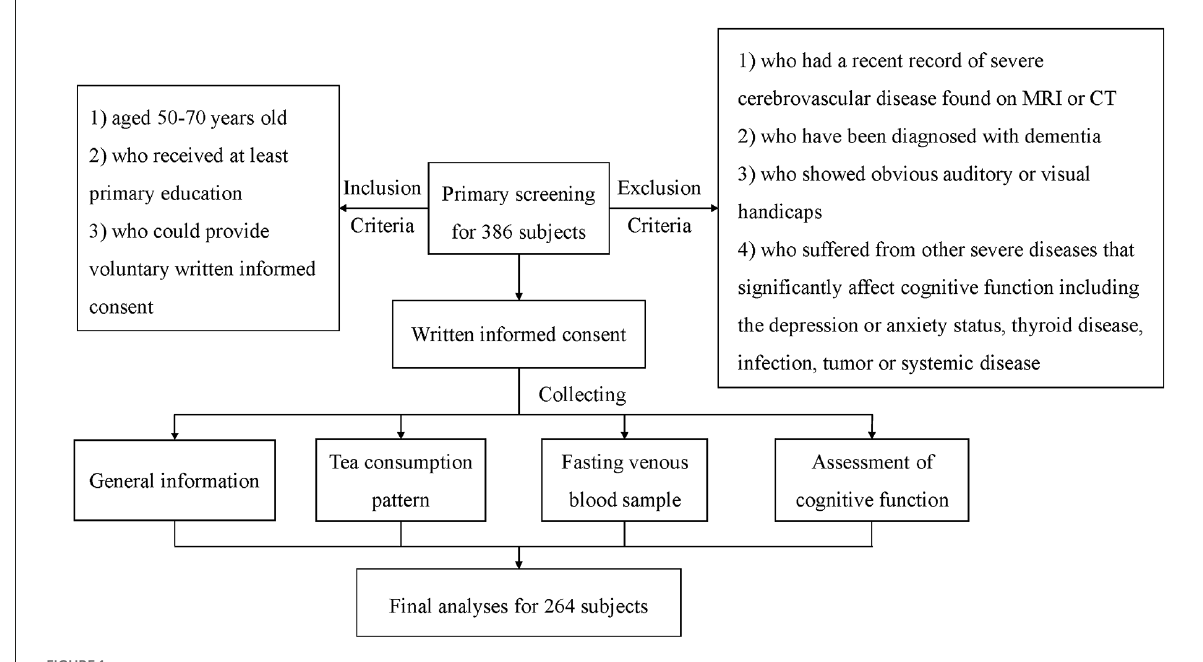
FIGURE1 Participant flowchart. MCI, Mild cognitive impairment.